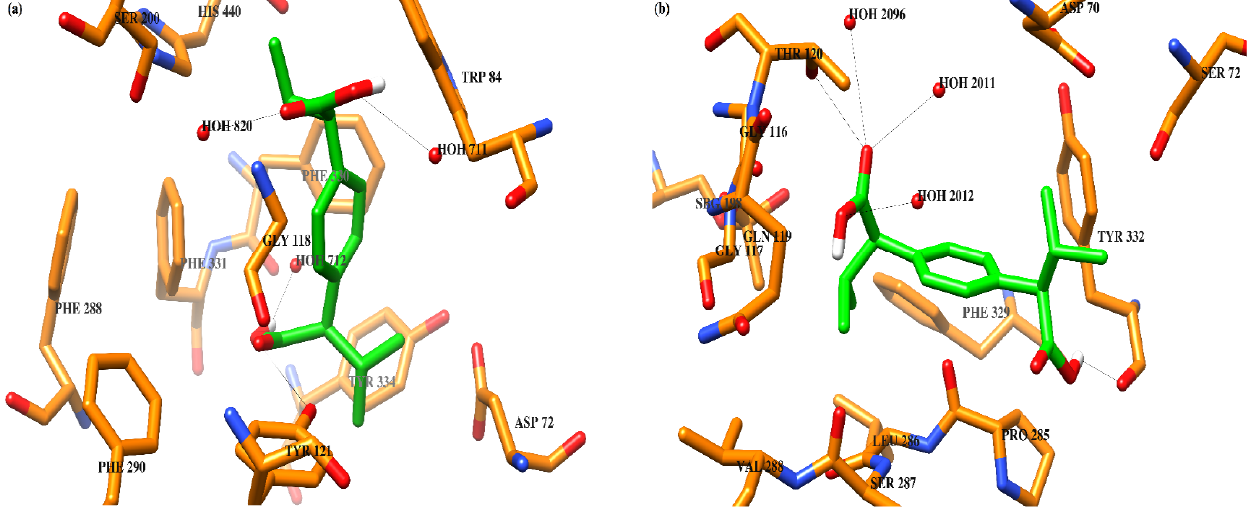
Figure 2. The binding mode of the most active compound XII (green) is shown in the active sites of ( a ) AChE (1QTI) and ( b ) BChE (4B0O). The active site residues are shown in the orange stick model, H ‐ bonds are depicted in black lines.